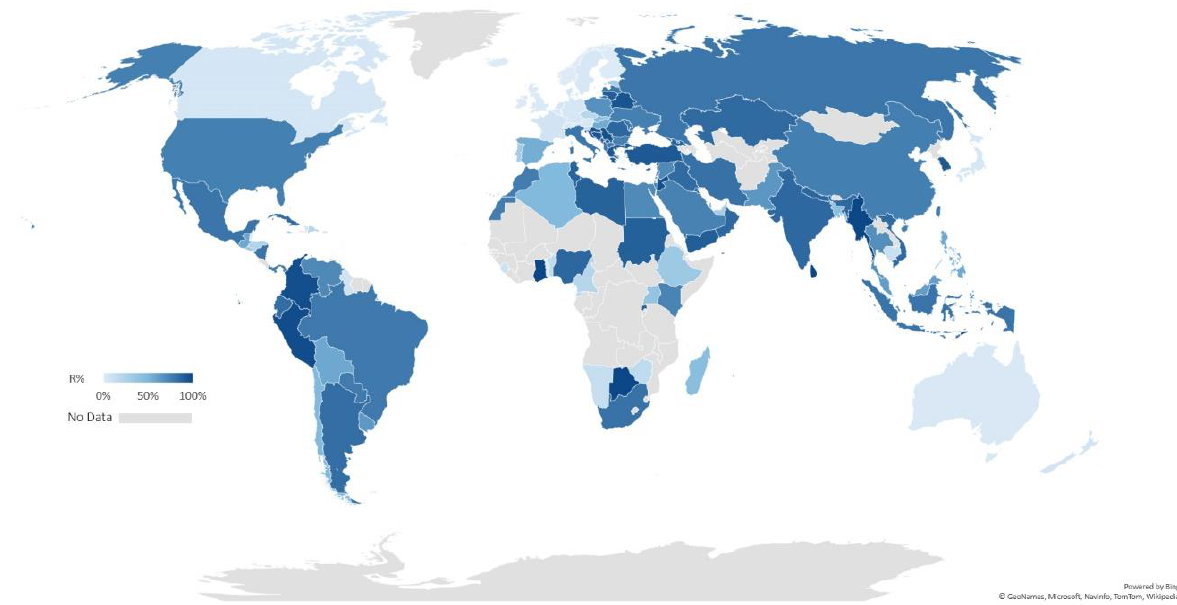
Figure 2. Global percentage of resistance to carbapenems (R%) of A. baumannii . The shade of blue represents the level of carbapenem resistance worldwide during the last decade (2009–2018). No suitable surveillance or research data is available for areas coloured in grey. A full list of all the statistics and sources is provided in Table S2, Supplementary Materials.